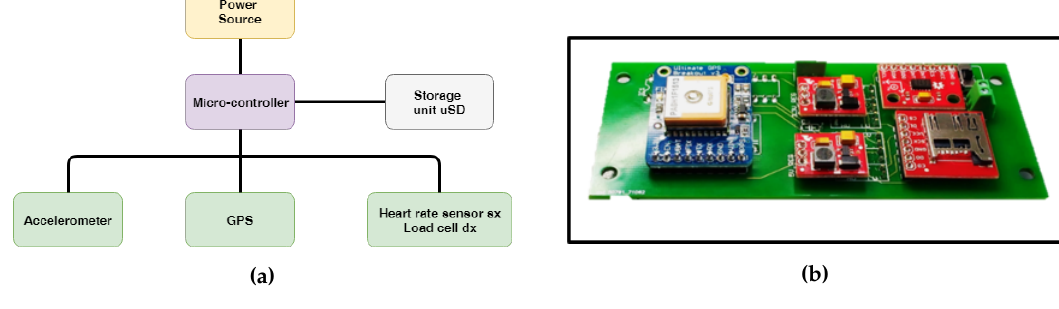
Figure 4. ( a ) Monitoring system layout; ( b ) data acquisition Printed Circuit Board